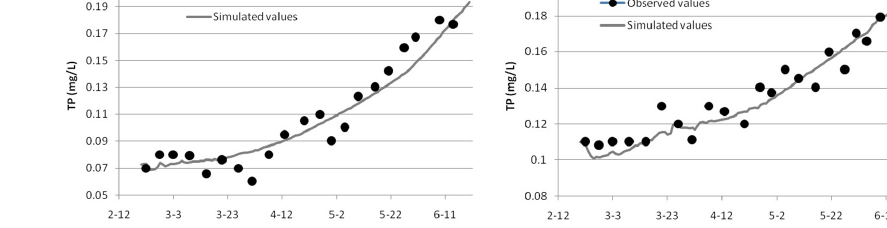
Figure 6. Calibration results for phosphate at sites 12 (a) and 11 (b) .